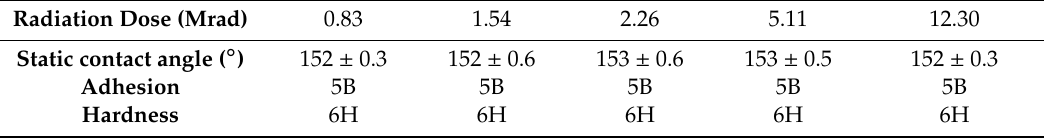
Table 2. Properties of the superhydrophobic surface after gamma